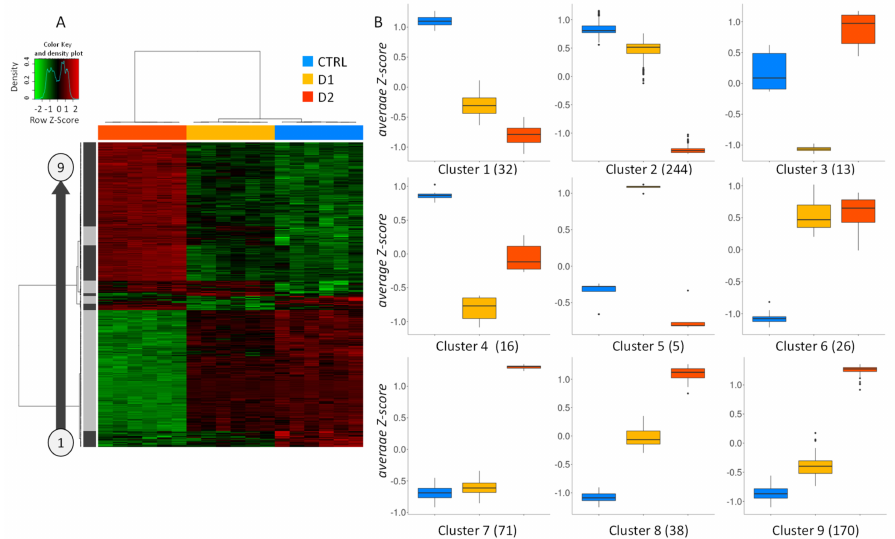
Figure 5. ( A ) Heatmap of the top 500 most significantly regulated genes in D1 vs. CTRL or D2 vs. CTRL comparisons. Red and green indicate values above and below the mean averaged centered and scaled log2cpm values (Z-score), respectively. Black indicates values close to the mean. According to the gene clustering (left panel), 9 gene clusters showed specific gene expression profiles. ( B ) Boxplots representing average Z-score of the 9 clusters (cluster 1 to cluster 9). Number of genes in each cluster is indicated in brackets.